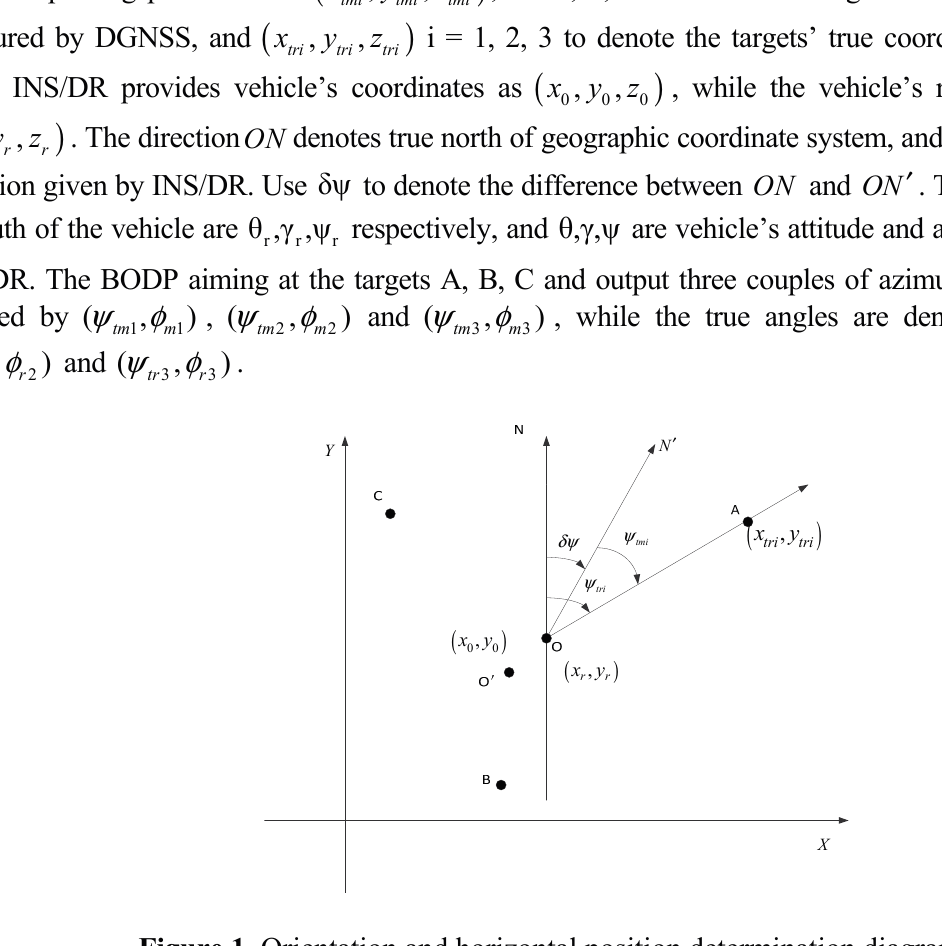
Figure 1. Orientation and horizontal position determination